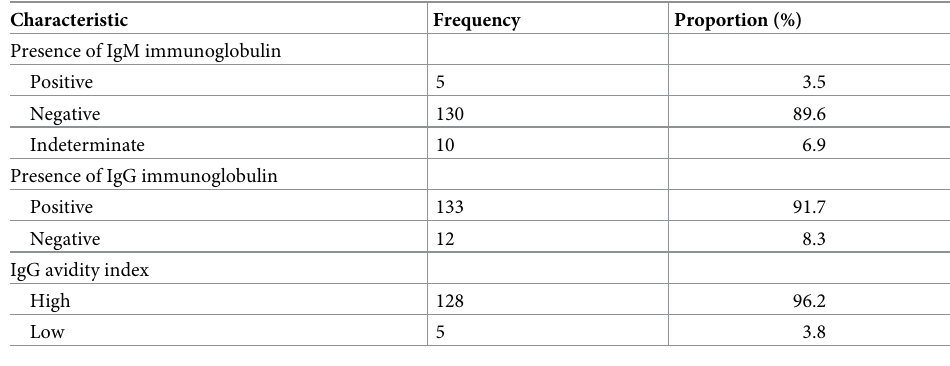
Table 3. IgM, IgG seroprevalence and IgG avidity.